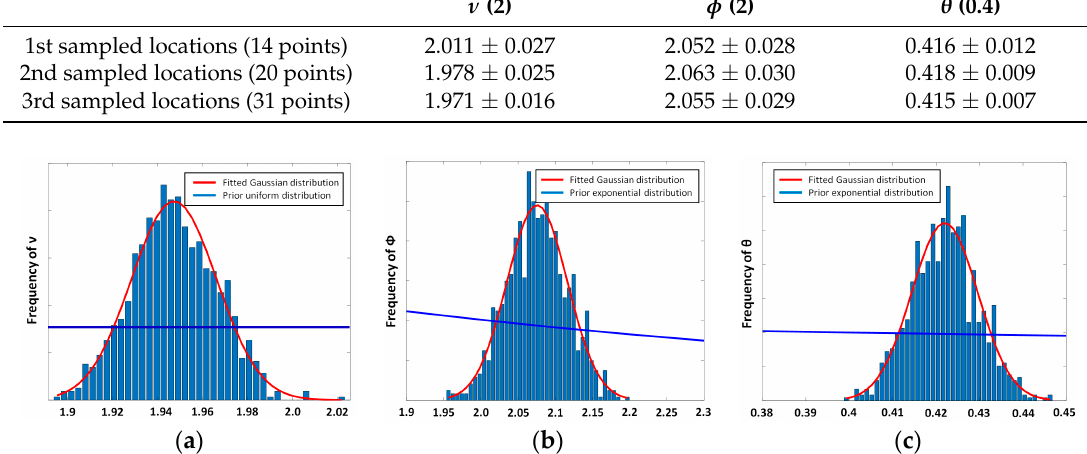
Figure 3. Probability density functions (PDFs) of the estimated parameters in Matérn covariance function: ( a ) ν , ( b ) φ , and ( c ) θ . The blue line is a part of the given prior PDF at the displayed region and blue histogram is the frequency of sampled parameters from the posterior PDF. The red curve is a fitted normal distribution to the histogram. The histograms and the prior PDFs are not in the same scale.